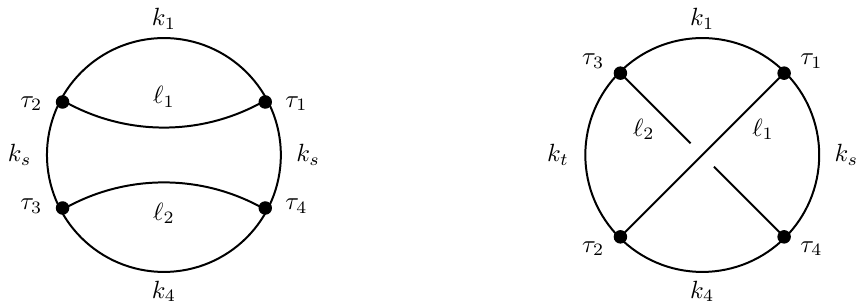
Figure 10 . The diagrammatic representation of the two types of four-point functions. The left diagram depicts the time-ordered four-point function (4.26) with (cid:28) 1 < (cid:28) 2 < (cid:28) 3 < (cid:28) 4 . The diagram on the right represents the out-of-time ordered four point function: in contrast with the geometric ordering, we assume that the four time instances are still ordered as (cid:28) 1 < (cid:28) 2 < (cid:28) 3 < (cid:28) 4 : The OTO correlation function is de(cid:12)ned via analytic continuation from the time-ordered correlation